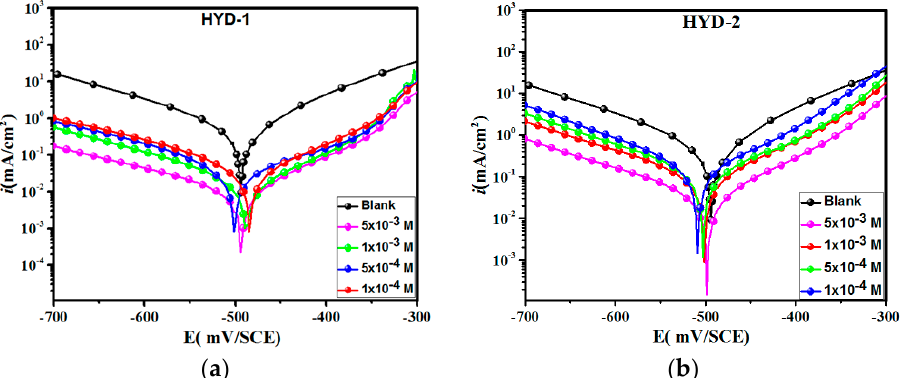
Figure 4. Potentiodynamic polarization curves for mild steel in hydrochloric acid solution with and without HYDs at 303 K, ( a ) HYD-1 and ( b ) HYD-2. Table 3. Electrochemical parameters derived after extrapolating the inhibited and uninhibited polarization